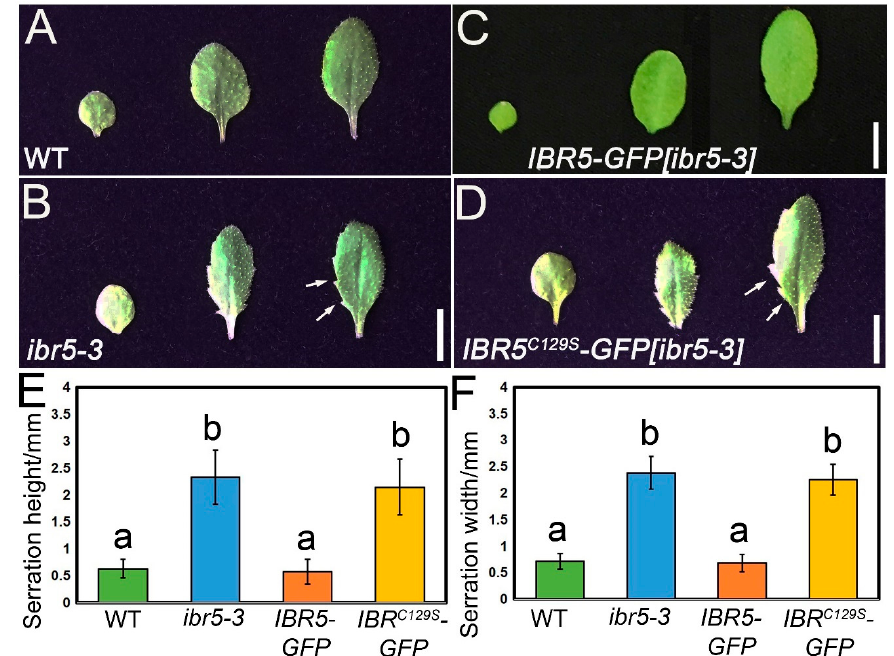
Figure 2. The functionality of IBR5 relies on its dual-specificity phosphatase activity. ( A ) Representative images of the first, second, and third leaves in the WT. Bar, 5 mm. ( B ) Representative images of the first, second, and third leaves in the WT. Bar, 5 mm. ( C ) Representative images of the first, second, and third leaves in IBR5 pro ::IBR5 genomic fragment –GFP rescued lines. Bar, 5 mm. ( D ) Representative images of the first, second, and third leaves in IBR5 pro ::IBR5 genomic fragment C126S –GFP rescued lines. Bar, 5 mm. ( E ) The maximum height analysis of the most proximal serrations of the third leaf in WT, ibr5-3 , and rescued lines. Error bars are ± SD, with 13 leaves analyzed. Di ff erent characters mean significant di ff erences ( p < 0.01 from Student’s t -test). ( F ) The maximum width analysis of the most proximal serrations of the third leaf in the WT and ibr5-3 . Error bars are ± SD, with 11 leaves analyzed. Di ff erent characters mean significant di ff erences ( p < 0.01 from Student’s t